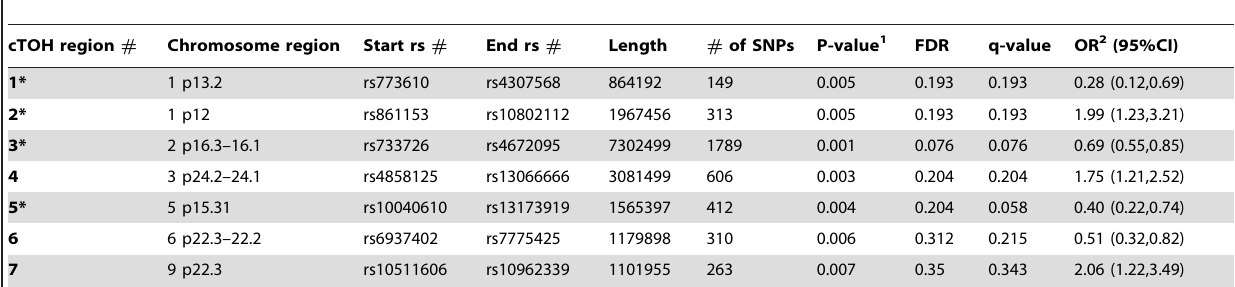
Table 1. Covariate-adjusted significant (p , 0.01) common tracts of homozygosity (cTOHs) over- or under-represented in lung cancer cases compared to